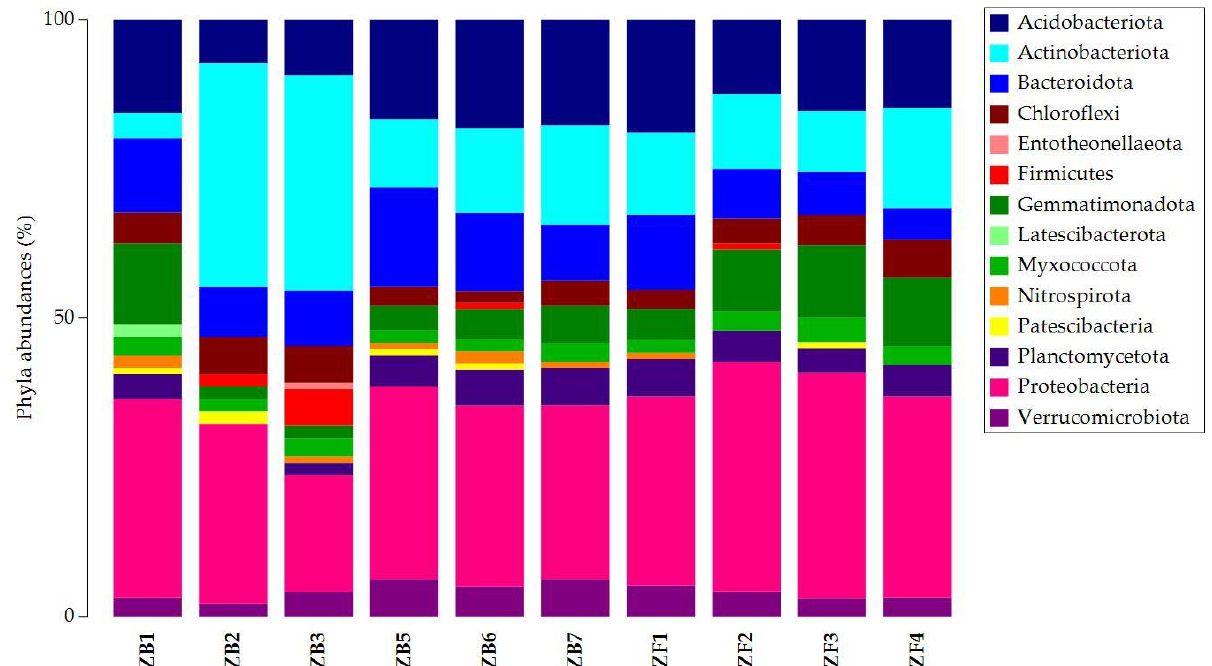
Figure 2. Taxonomic bar plot of the relative abundances of bacterial phyla associated with individual soil samples.